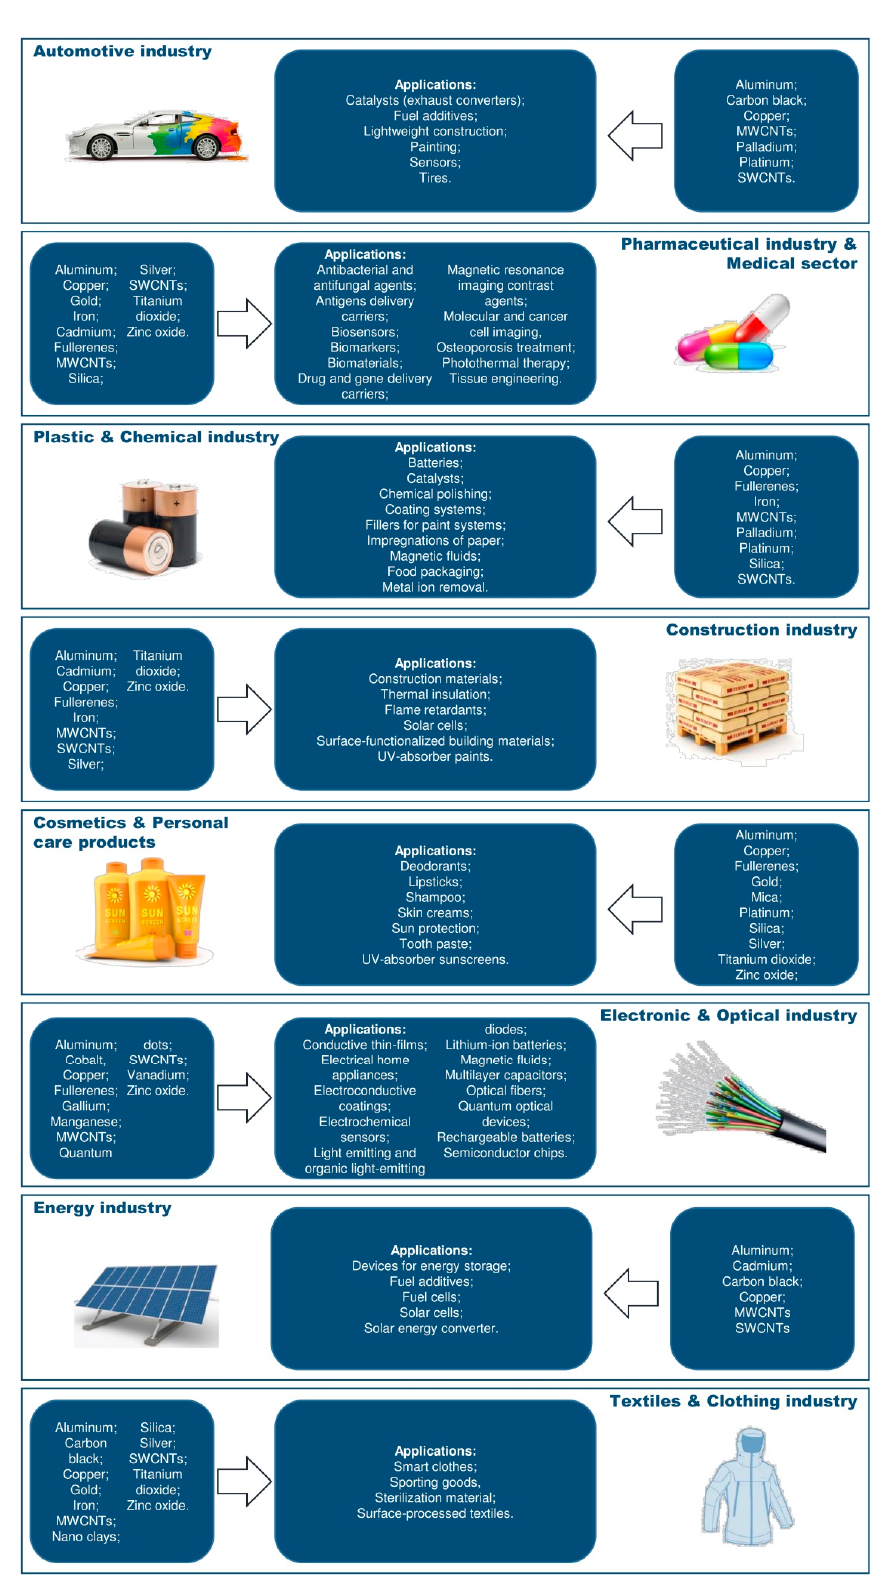
Figure 1. Main industrial uses and consumer product applications of engineered nanomaterials.